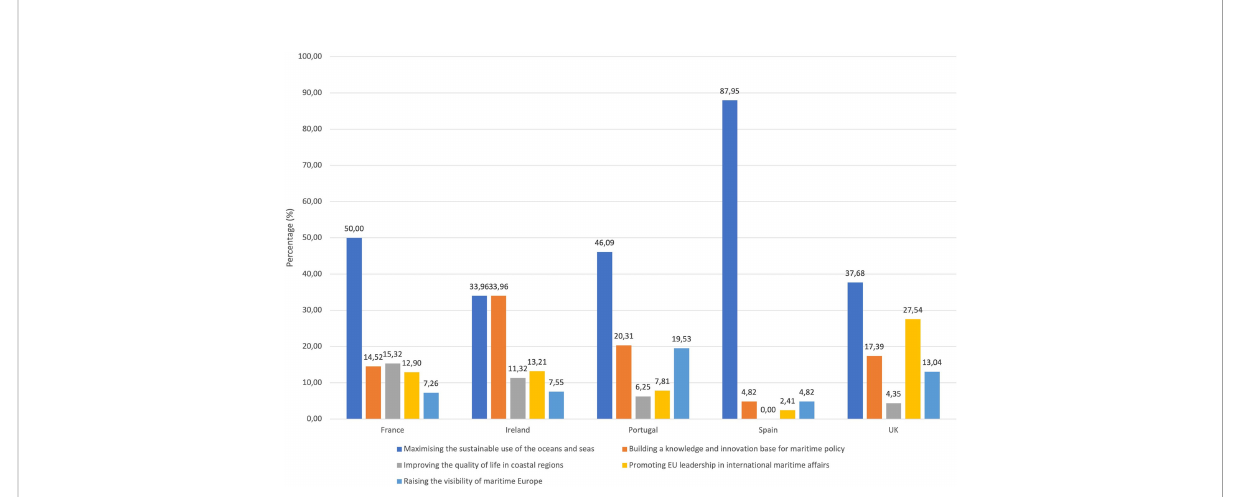
FIGURE 10 Percentage of measures of the fi ve National Ocean Strategies analyzed within the framework of the IMP Action Areas. Source: Created by the